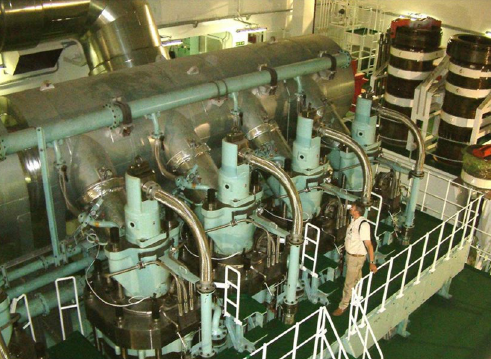
Fig. 4 Container vessel, Monte class, main engine (source: Wikimedia Commons, the image belongs to the public